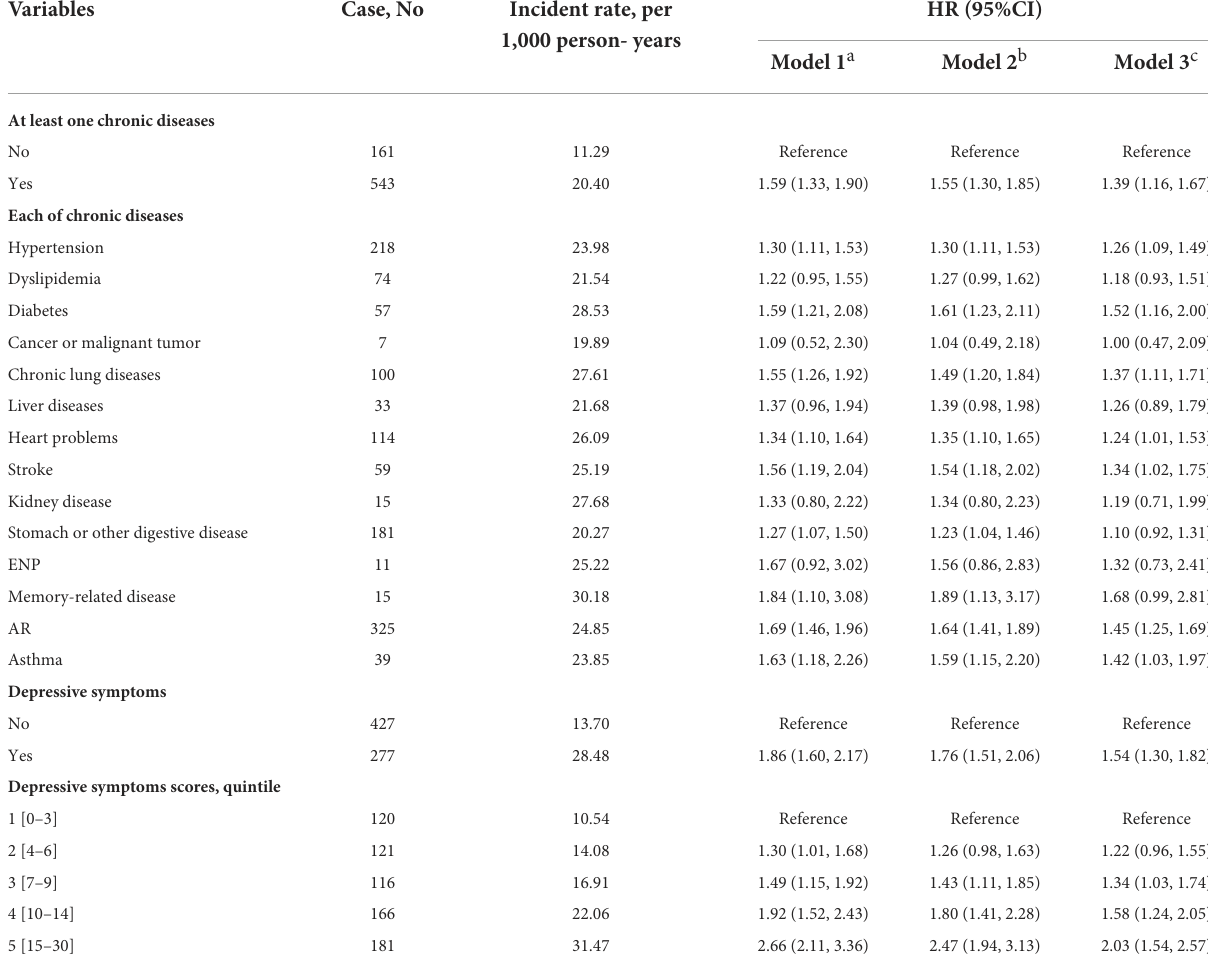
TABLE 2 Association between chronic diseases, depression symptoms and ADL